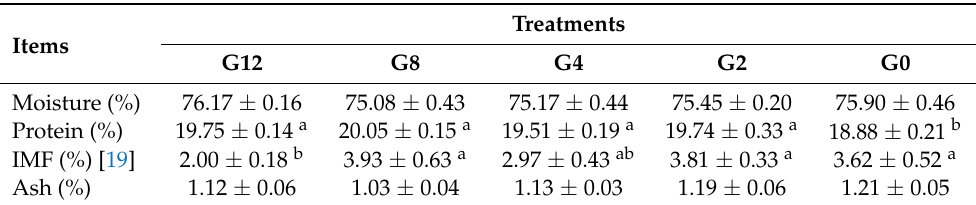
Table 4. Chemical composition of LT muscle in Tan lambs under different restricted grazing time and indoor supplementary feeding